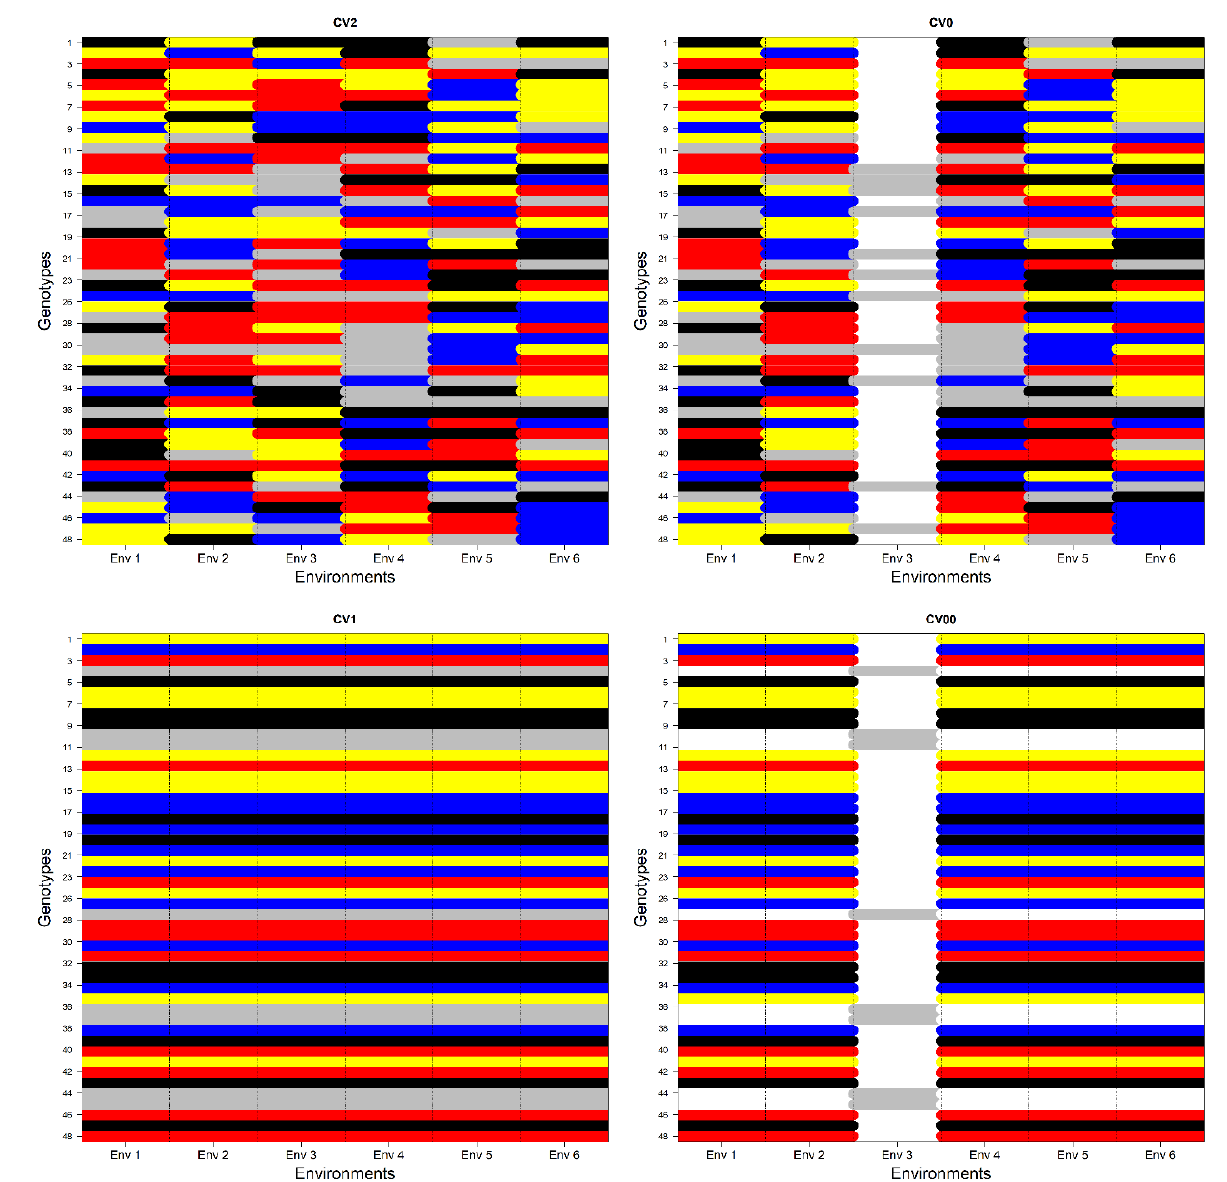
Figure 2. Graphical representation of four cross-validation schemes (CV2, predicting tested genotypes in observed environments; CV1, predicting untested genotypes in observed environments; CV0, predicting tested genotypes in unobserved environments; and CV00, predicting untested genotypes in unobserved environments) that preserve comparable training and testing set sizes. The colored horizontal lines correspond to a fivefold assignation of phenotypes (CV2; top left ) and genotypes (CV1; bottom left ) for composing training and testing sets (e.g., consider 4 folds for a training set: black, blue, red and yellow horizontal lines; while for testing set only one fold is considered: gray color lines). For CV0 ( top right ) and CV00 ( bottom right ), the genotypes represented with horizontal gray lines in environment 3 (Env 3) correspond to the target prediction set. In addition, for CV00 the horizontal white lines in the remaining environments (1–2, 4–6) correspond to missing phenotypic information of the target genotypes in other environments. Similar volumes of information for model training are employed for predicting comparable testing set